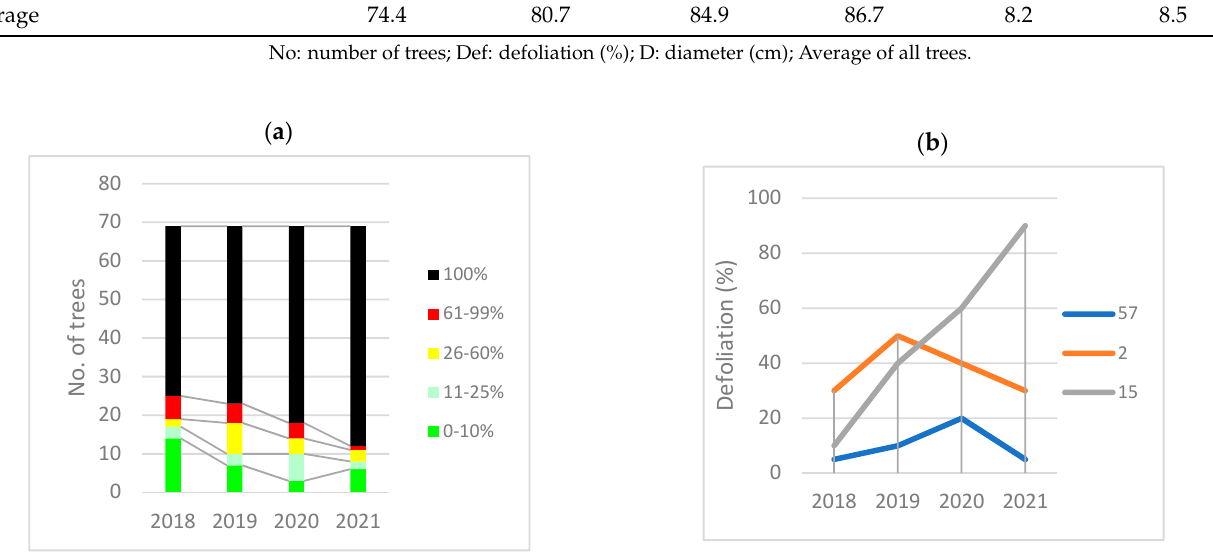
Table 6. Defoliation and diameter evolution of Ulmus laevis provenances.